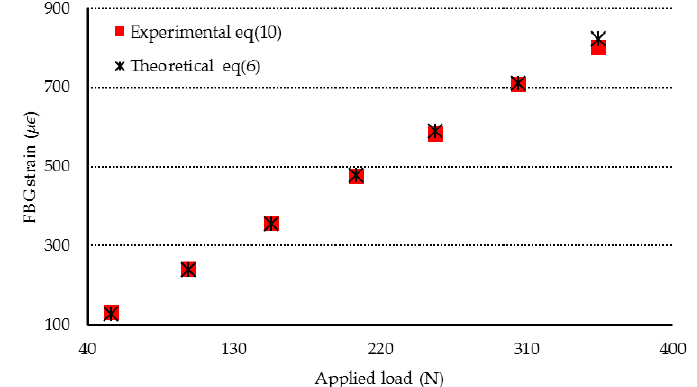
Figure 6. Strain transferred from the Al specimen to the bonded FBG in the three-point bending test with various loadings.